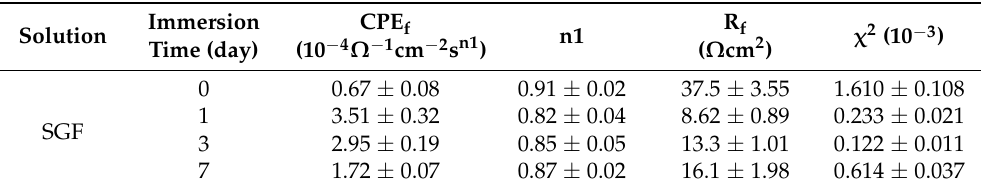
Table 2. Fitting data of EIS for Zn–0.4Li after immersion in SGF for different times.